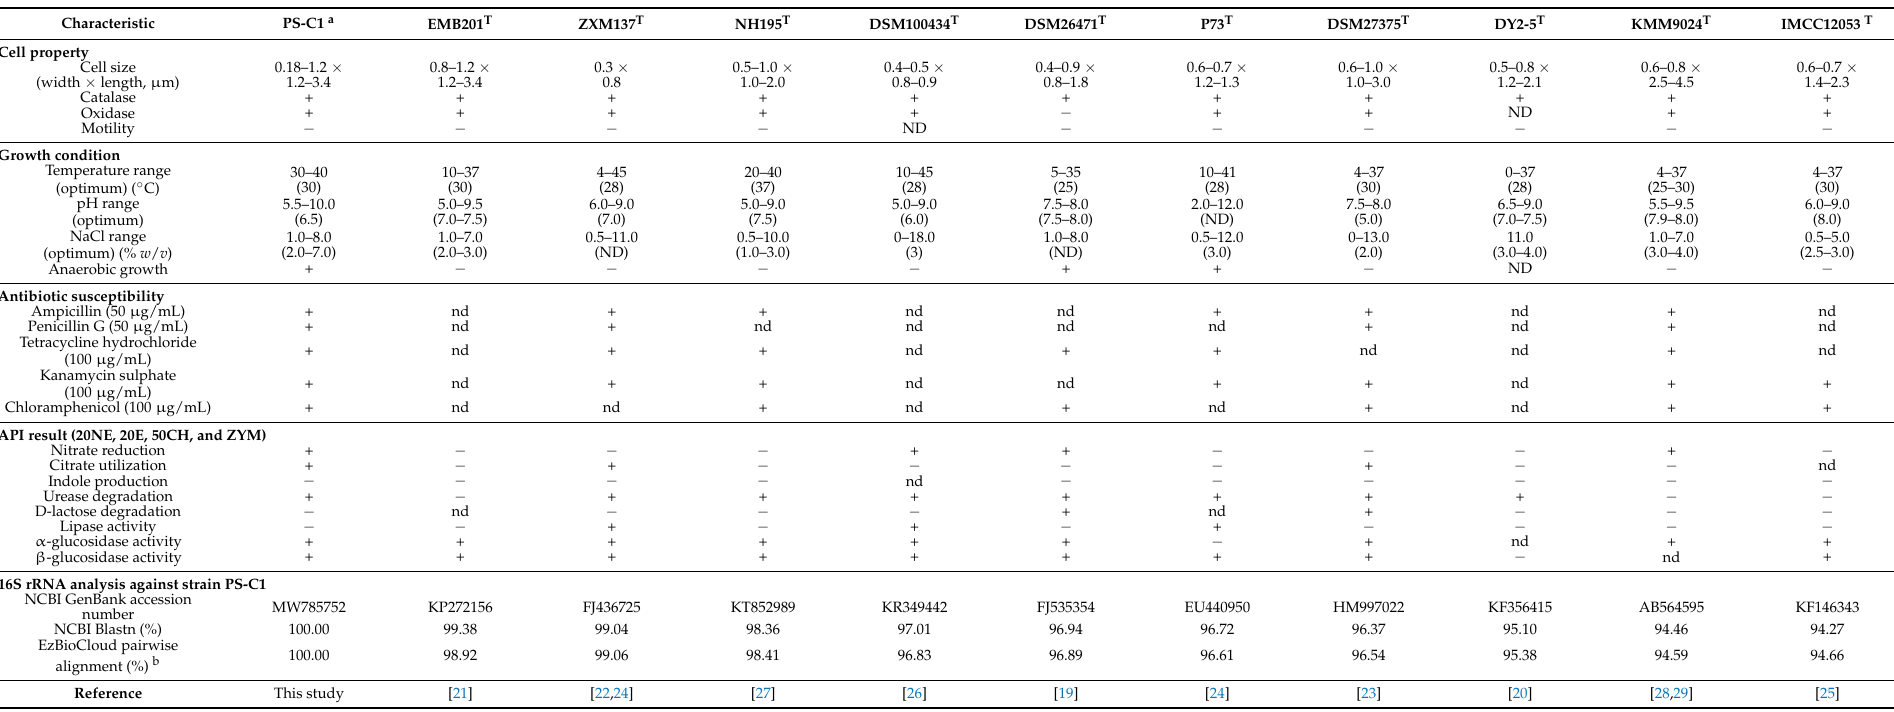
Table 1. Comparison of morphology and biochemical characteristics between strain PS-C1 and type strains of the genus